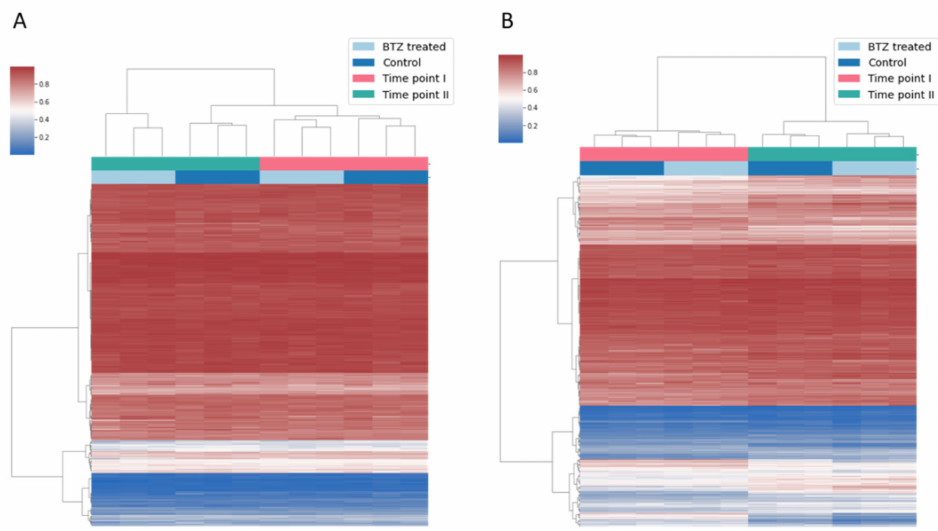
Figure 4. Heatmap illustrating unsupervised clustering of methylation changes identified to be affected by BTZ treatment in dLUHMES cells, based on data from our previous study of SH-SY5Y cells ( A ); heatmap illustrating methylation at the subset of CpGs previously identified to be affected by BTZ treatment in SH-SY5Y cells, based on data from the current study for dLUHMES cells ( B